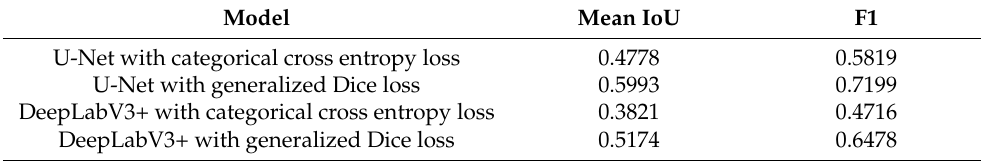
Table 2. U-Net and DeepLabV3+ trained using categorical cross entropy and generalized Dice loss.